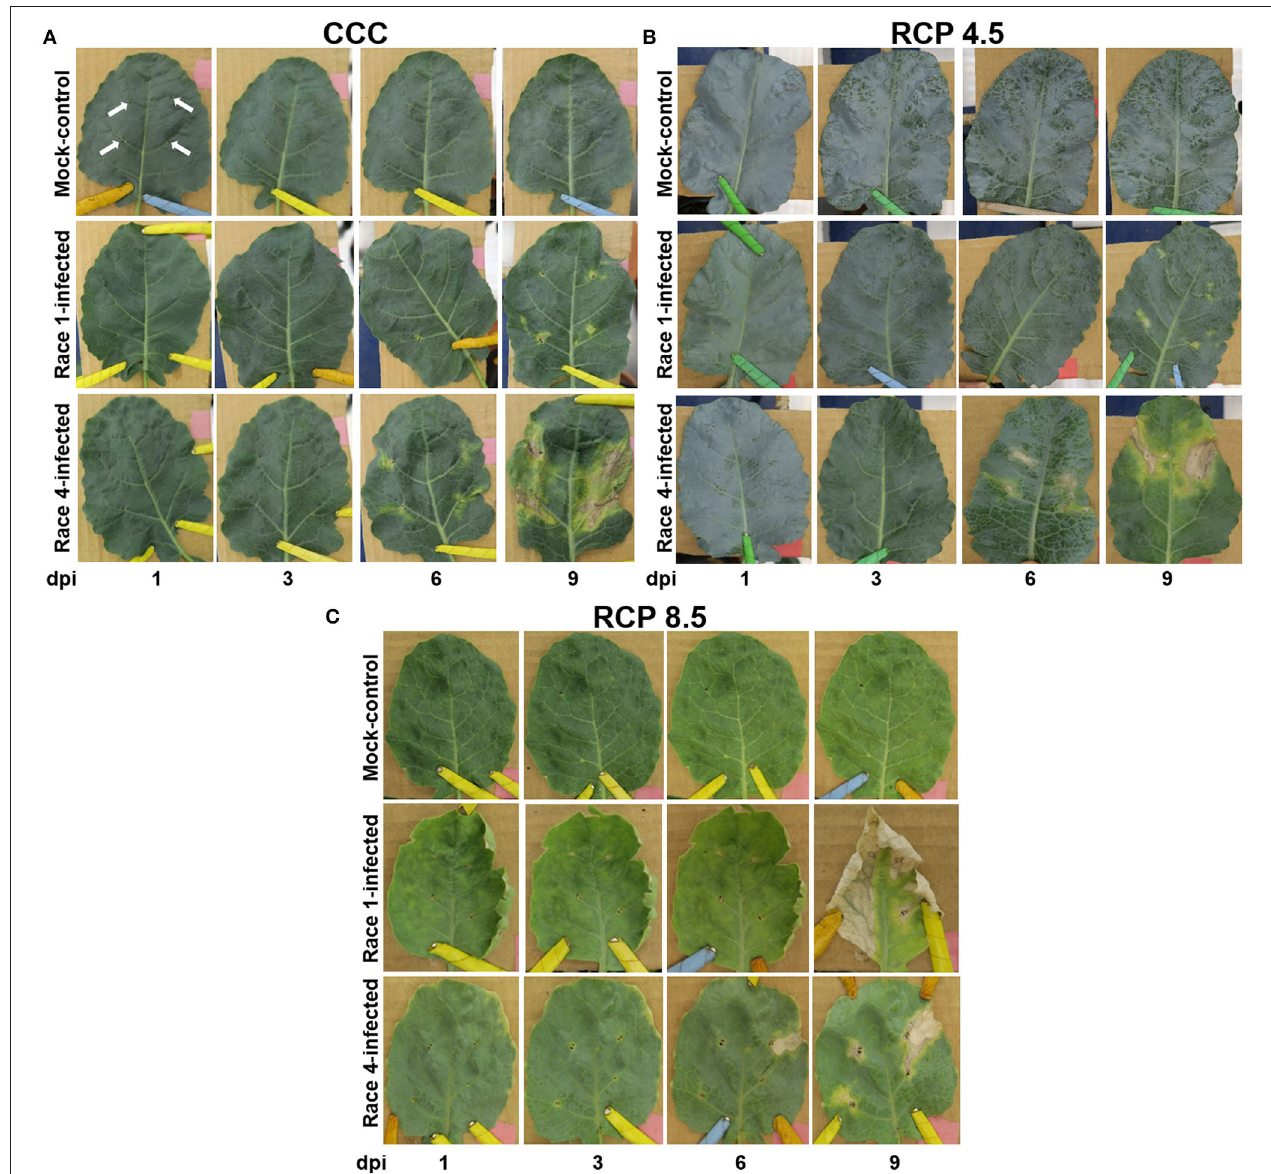
FIGURE 1 | Timecourse of symptoms evolution of mock-control, Xcc race 1-infected, and Xcc race 4-infected broccoli plants at current climate conditions ( A ; CCC), and the representative concentration pathways RCP 4.5 (B) and RCP 8.5 (C) . White arrows indicate the inoculation points. For simplicity, they have only been shown in mock-controls leaves at CCC. Dpi, days